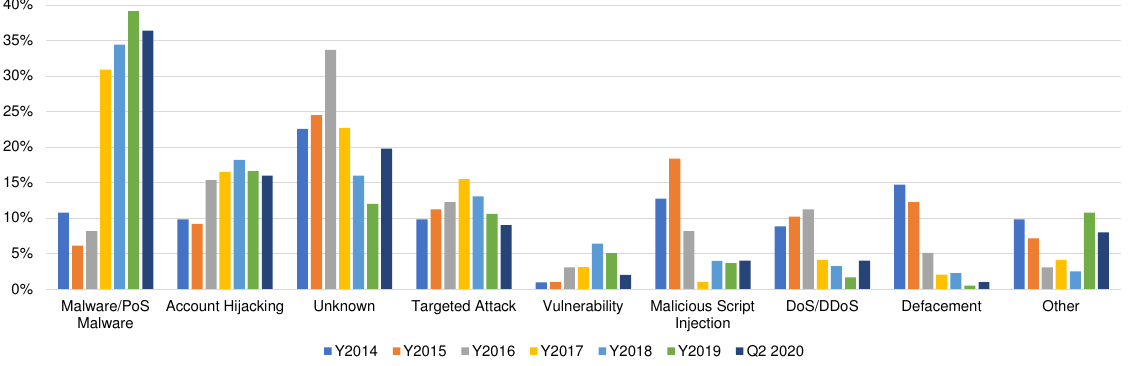
Figure 1. Attack distribution techniques from 2014 to Q2